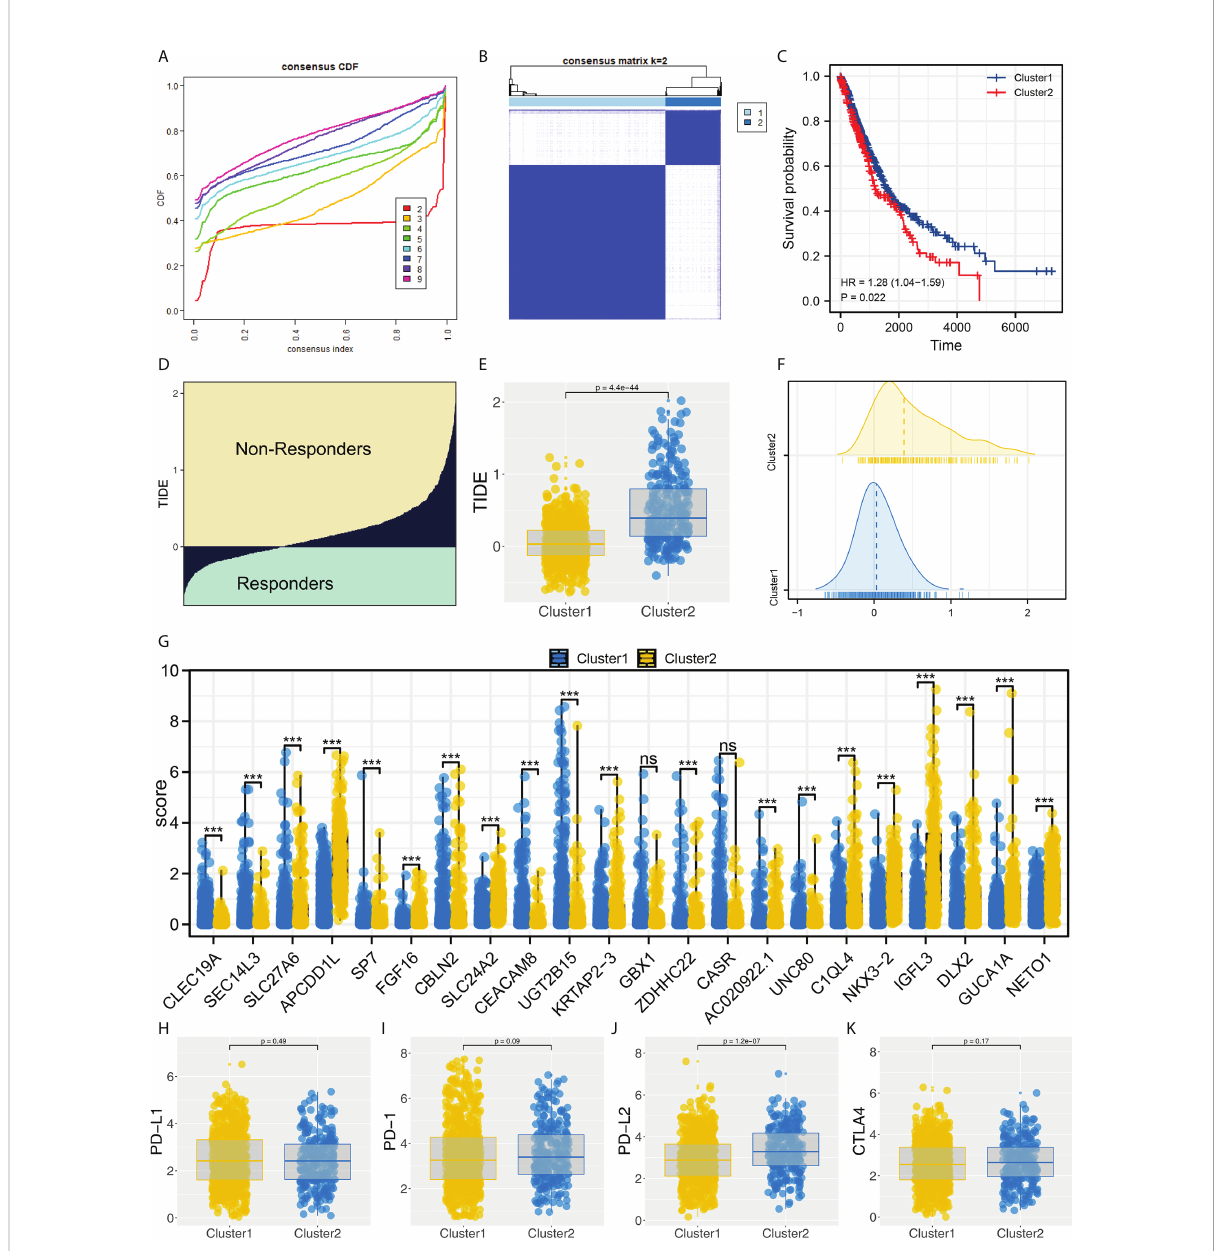
FIGURE 2 Molecular typing based on identi fi ed characteristic genes. (A) ConsensusClusterPlus package was used for molecular typing; (B) Two subtypes provide the best differentiation; (C) KM survival curve showed that Cluster2 patients had a worse prognosis; (D) The calculated TIDE score of TCGA patients, of which TIDE scores > 0 were non-responders and < 0 were responders; (E, F) The patients in Cluster2 had a higher TIDE score; (G) The expression level of characteristic genes in Cluster1 and Cluster2 patients, ns = P < 0.05, *** = P < 0.001; (H – K) The PD-1, PD-L1, PD-L2 and CTLA4 expression in Cluster1 and Cluster2